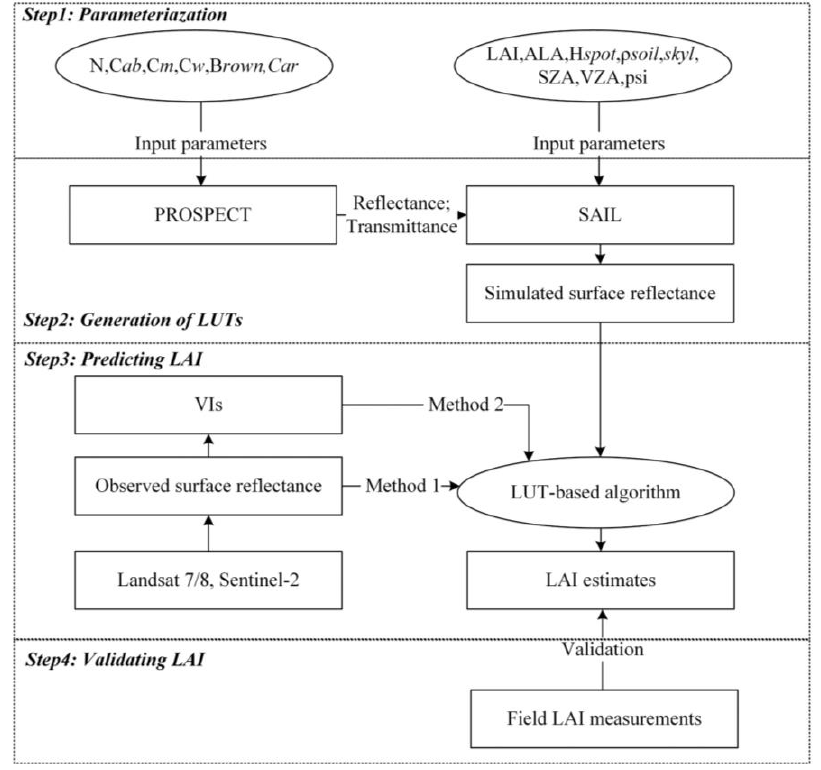
Figure 3. Process flow of model derivation and validation